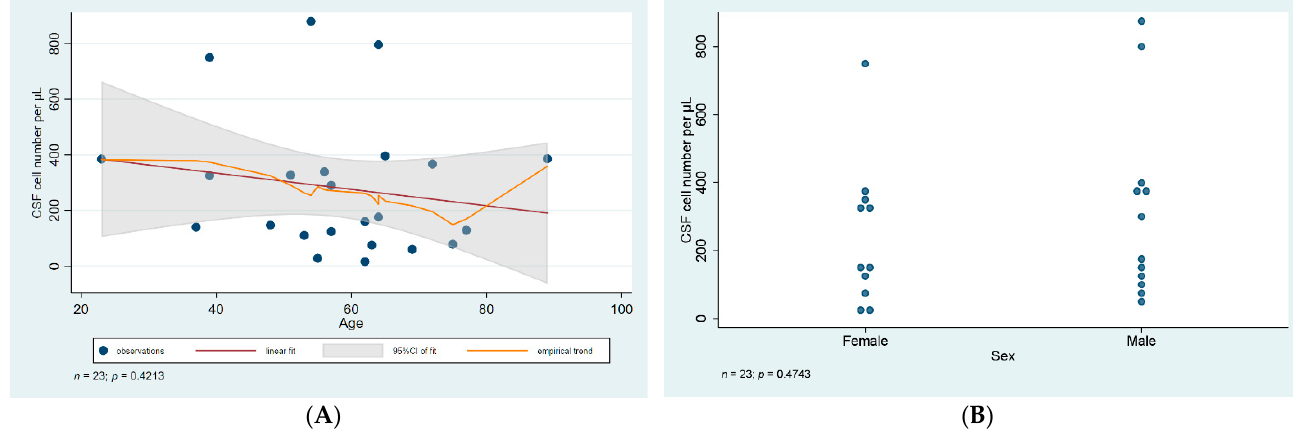
Figure 1. Statistical analysis of CSF cell number. ( A ) Scatter plot of CSF cell number against age with linear regression fit and empirical trend superimposed. ( B ) Categorical scatter plot of CSF cell number by sex. CSF—cerebrospinal fluid; CI—confidence interval.